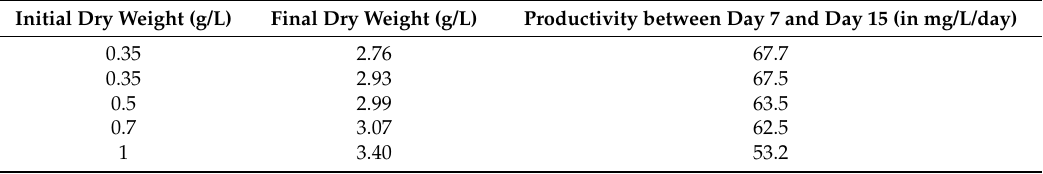
Table 2. Final dry weights (day 27) and productivity between day 7 and day 15 for different initial dry weights in modified ZM.